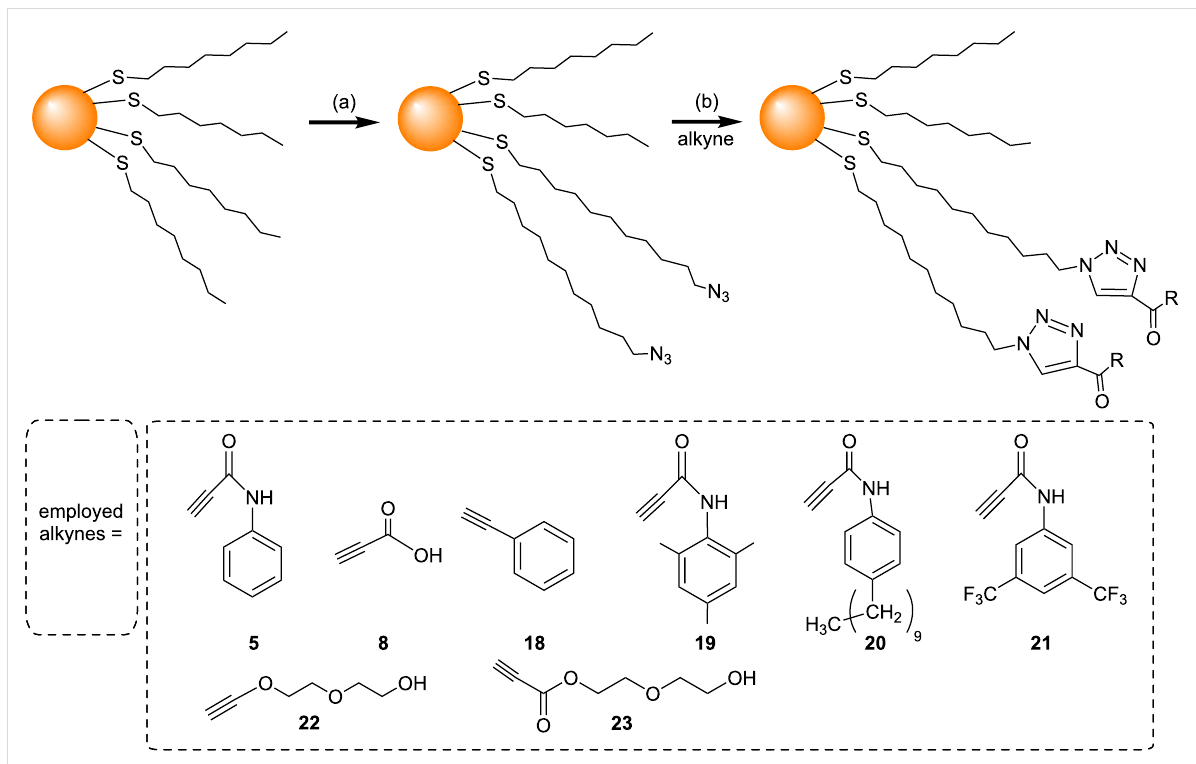
Scheme 8: Surface modification of AuNPs using microwave-assisted CuAAC. Reagents and conditions: (a) HS(CH 2 ) 11 N 3 , C 6 H 6 , rt, 7 h; (b) dioxane/ t- BuOH/H 2 O or THF, CuSO 4 , sodium ascorbate, microwave heating (1000 W), 5–10 minutes [61].